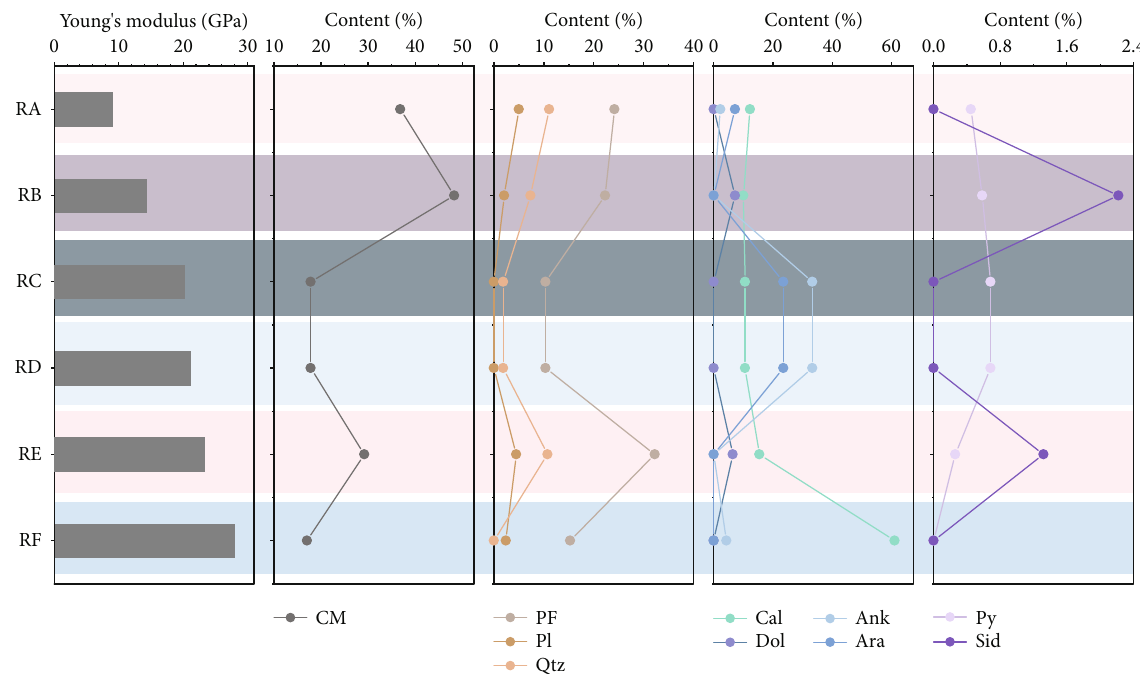
Figure 9: Characteristics of mineralogical composition and Young ’ s modulus for the di ff erent samples.